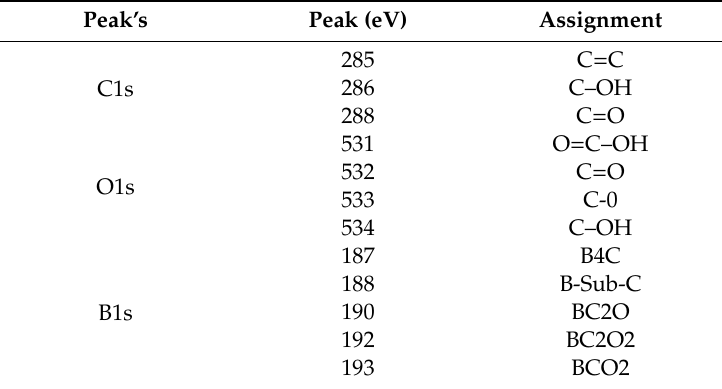
Table 2. The XPS peak assigned to each functional